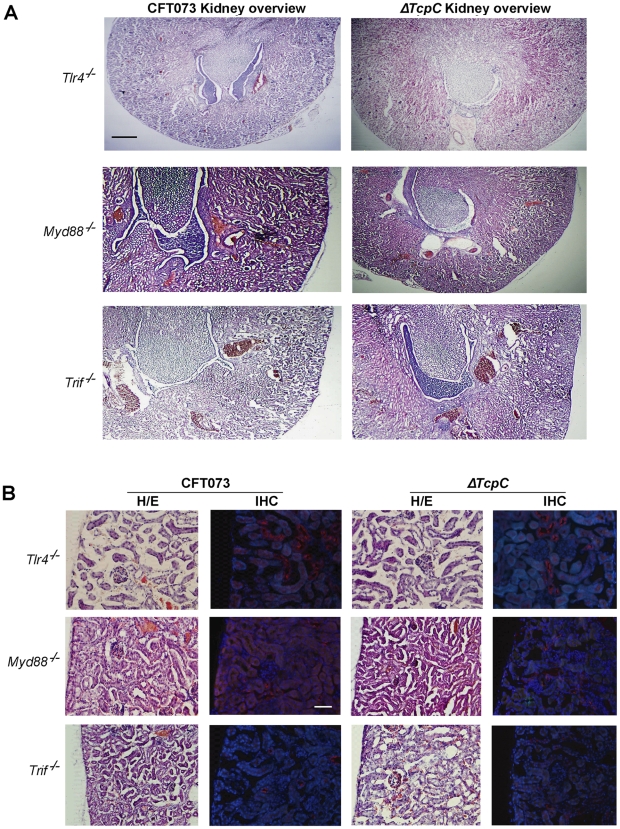
Morphology of intact kidney tissue in Tlr4 −/− and adaptor protein mutant mice infected with CFT073 and ΔTcpC.(A) Overview of htx-eosin stained kidney section of Tlr4−/−, Myd88−/− and Trif −/− mice. Scale bar, 500 µm. (B) Histology of renal cortex stained with specific antibodies to neutrophils (green, NIMP-R14) or the PapG adhesion (red, antiserum to a synthetic PapG peptide). Scale bar, 100 µm. Neutrophils or bacteria were not detected in the tissues. The Tlr4−/− and Myd88−/− mice were compared to C57BL/6 wt mice and Trif −/− mice to C57BL6/129 wt mice.